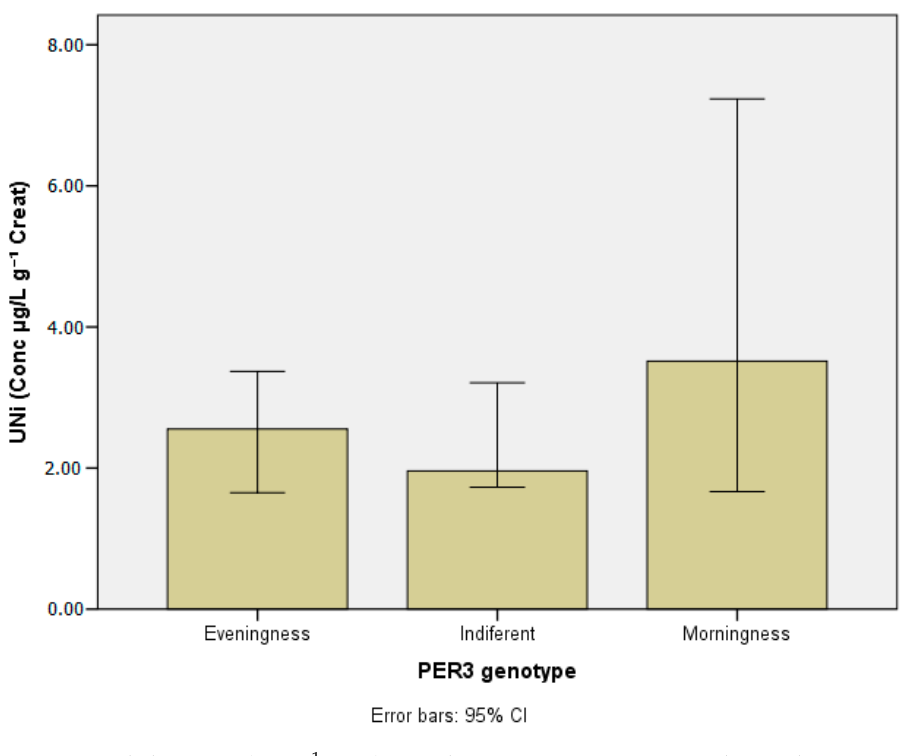
Figure 7. Nickel in urine ( μ g g − 1 creat) according to PER3 gene VNTR polymorphisms.